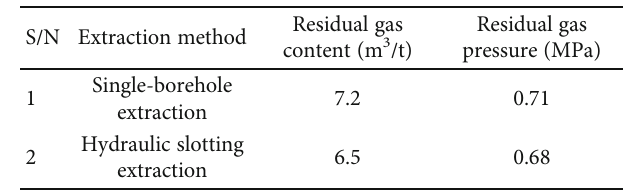
Table 2: Outburst prevention index after